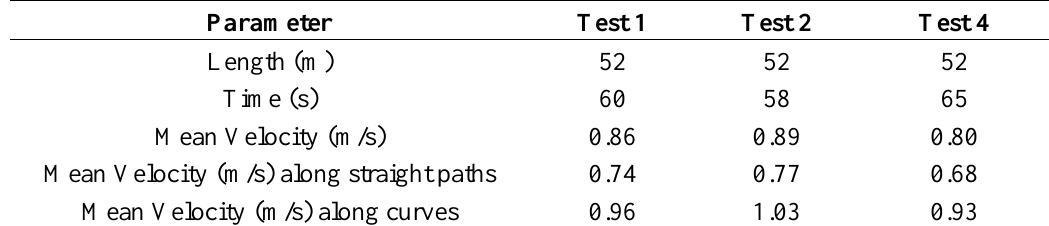
Table 5. Comparison between paths of type 1 (simple paths).